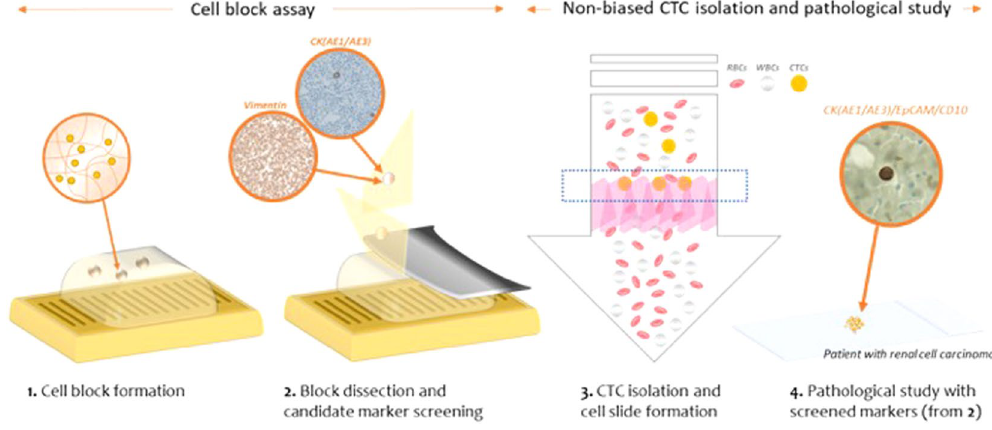
Figure 1. The schematic diagram of the present work for the pathological study of the circulating tumor cells filtered from the cancer patients’ blood samples.